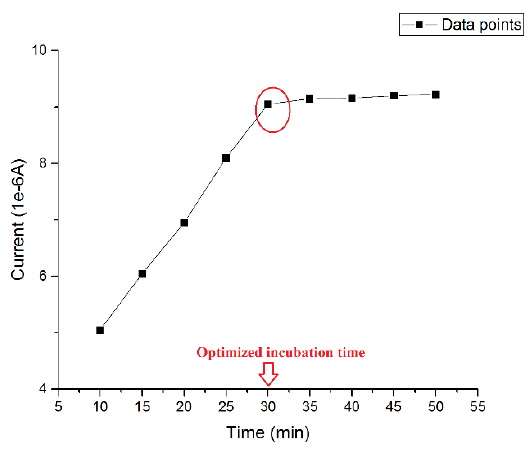
Figure 1. Optimized incubation time of β-amyloid 42.